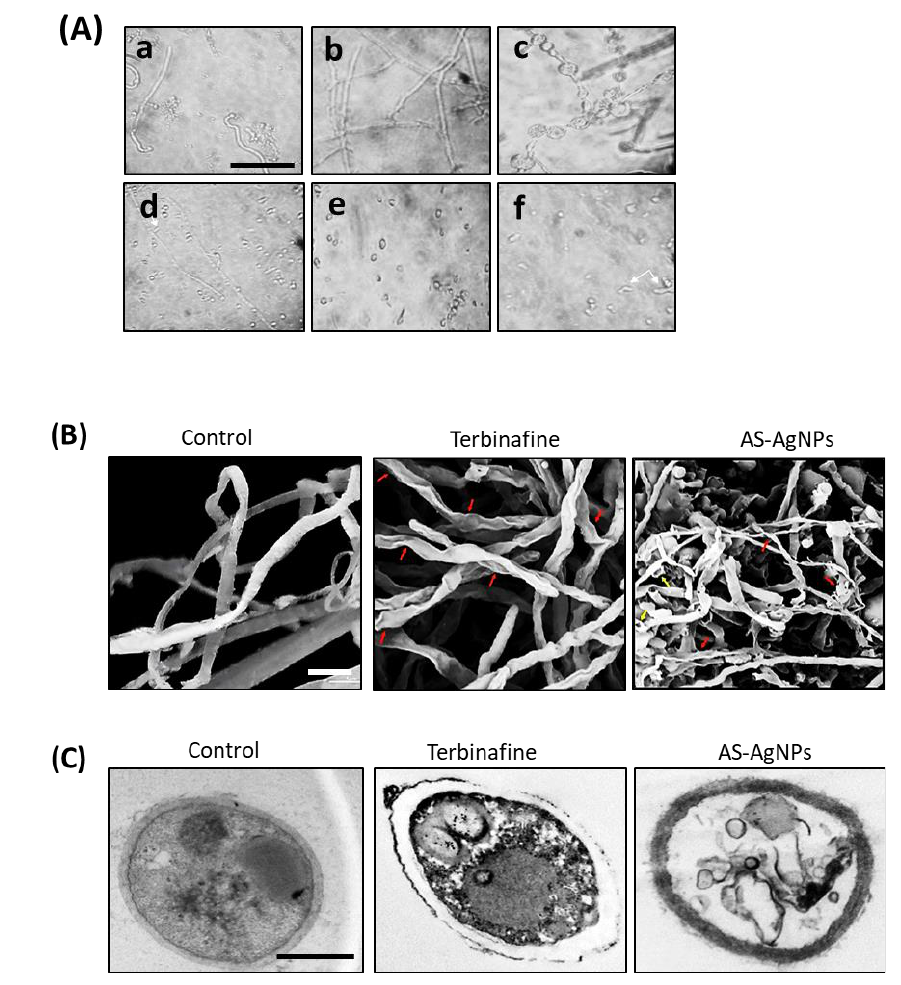
Figure 6. Effect of AS-AgNPs on cell morphology of T. rubrum . ( A ) Inverted phase-contrast micro- scope images of T. rubrum with different treatments. ( a ) Saline-treated fungus display germination that started 4 h subsequent to the incubation of spores. ( b ) Normal structure of hyphae after 72 h incubation. ( c ) Terbinafine- treated cells (256 μg /mL) displaying different modifications; thick broader hyphae with vacuoles, tiny elongated hyphae with tear-shaped microconidia (arrow) ( d ). ( e ) AS-AgNP- treated cells (128 μg /mL) showed inhibition of spore germination. There are malfor- mations, cellular injuries, and dumpy necrotic hyphae (arrow) ( f ). 400× (bar 100 µm). ( B ) SEM of T. rubrum treated with saline, terbinafine (256 μg /mL), and As- AgNPs (128 μg /mL). The saline-treated sample (negative control) displays normal tubular and uniform hyphae. The terbinafine – treated cells (positive control) show minor distortion in the shape of the cells and collapse in cell wall (red arrows); however, significant modifications are obvious in the case of AS-AgNP-treated cells where there are the fragmentation of cells into flat shapes (red arrows) and the leakage of intracellular material after damage (yellow arrows). Bar = 2.5 μm . ( C ) TEM of T. rubrum treated with saline, terbinafine, and As-AgNPs. The fungal hyphae displayed morphological alterations once subjected to terbinafine and As-AgNP. T. rubrum treated with terbinafine showed damage of cytoplasm con- tent and the cell membrane started to separate itself from the cell wall. Meanwhile, the treatment of T. rubrum with AS-AgNPs resulted in the complete destruction of the fungal hypha through lysis, and the cell wall and compartment were completely damaged. Bar = 250 nm.